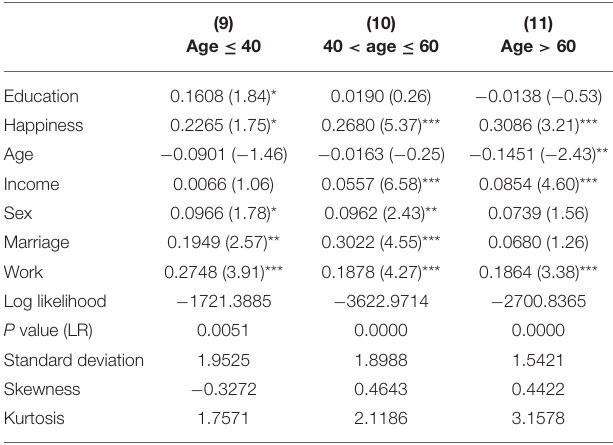
TABLE 4 | Grouping test results